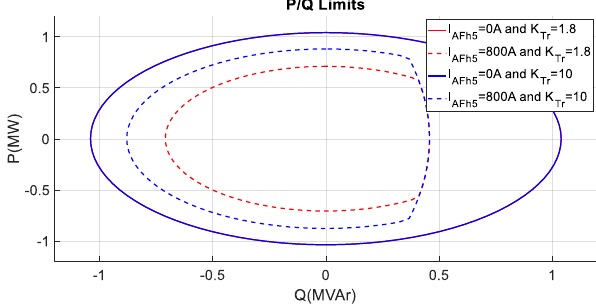
Figure 14. Maximum active and reactive power injection capability for two 5th harmonic currents (DHC) of 0 and 800 A at nominal voltage. In order to show the de-rating effect, two different k-factors for the transformer are considered.